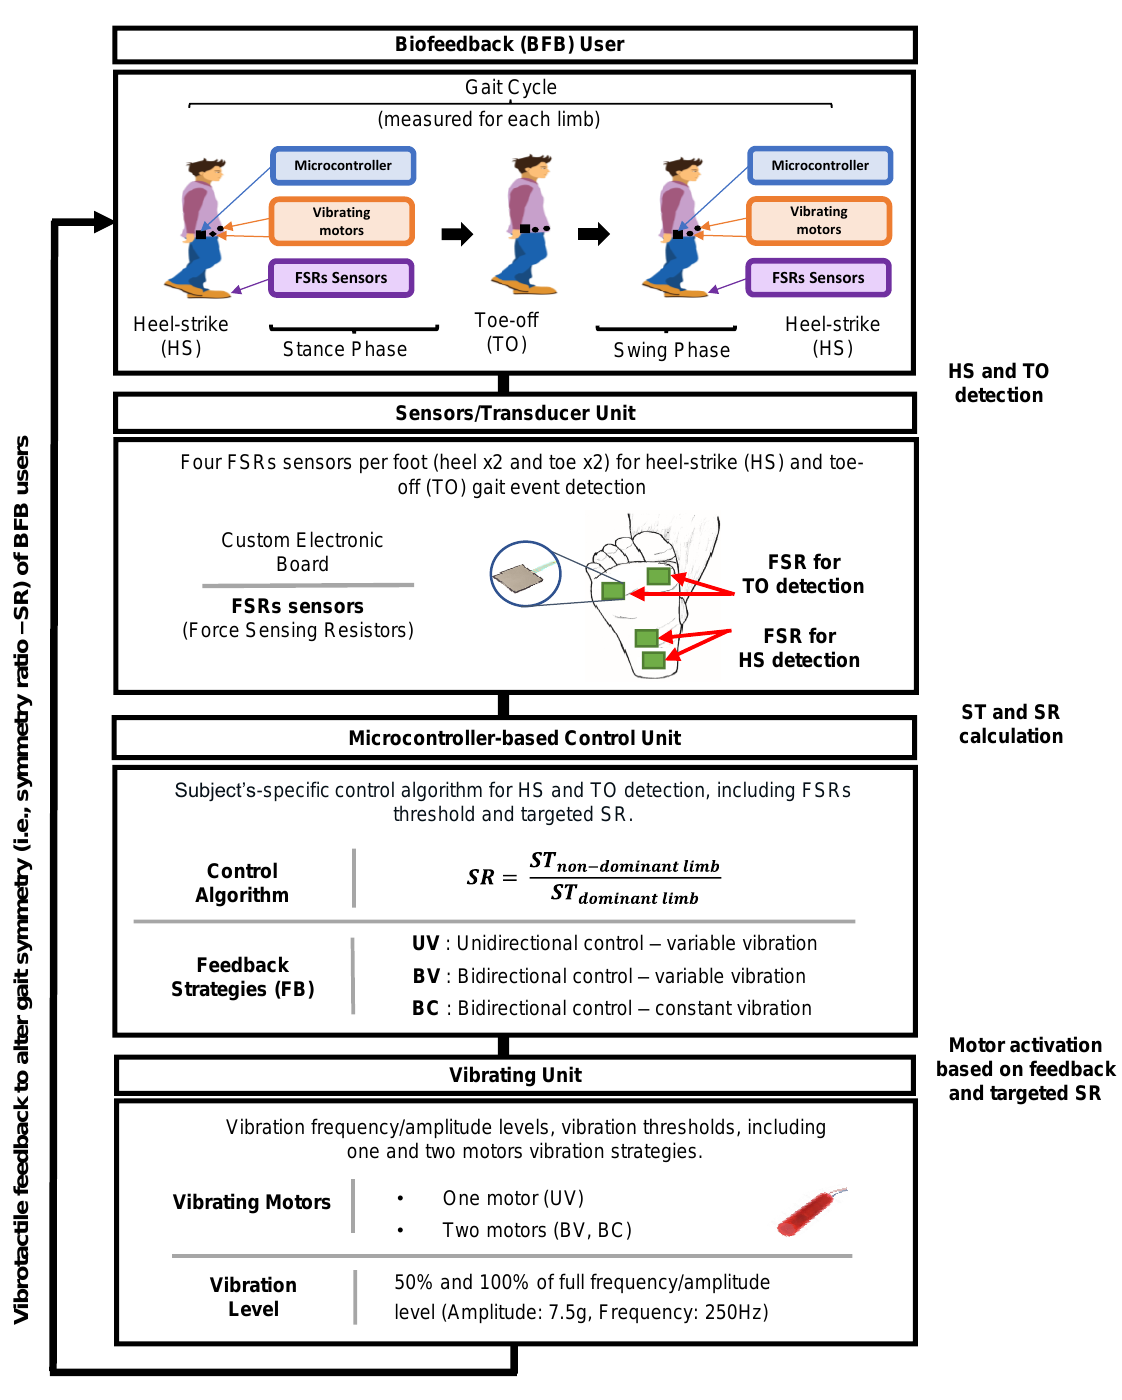
Figure 2: Control diagram of the BFB system to modulate symmetry ratio (SR). The closed-loop system includes system components, feedback strategies, and system